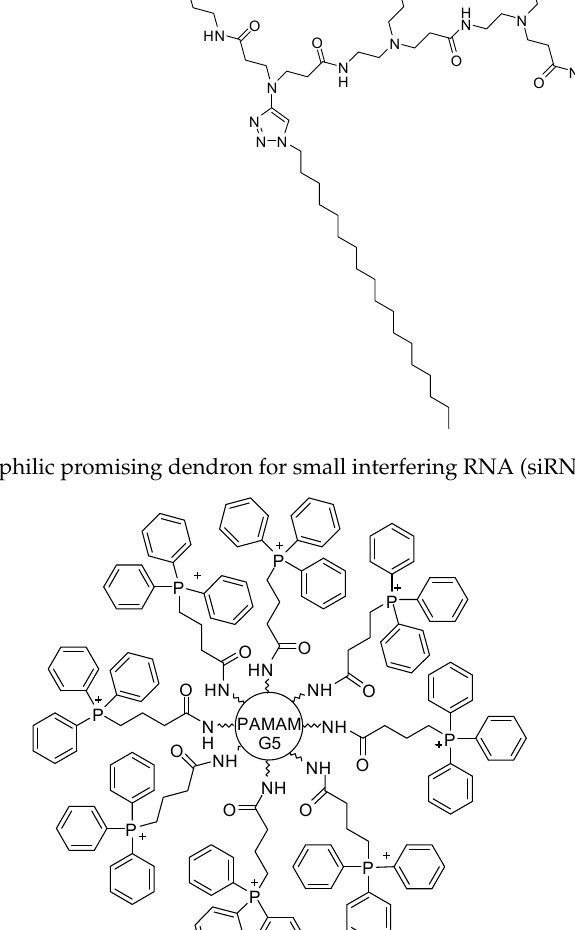
Figure 12. Dendrimer E9-2 with a high ability of gene transfection in a stem cell model [102].